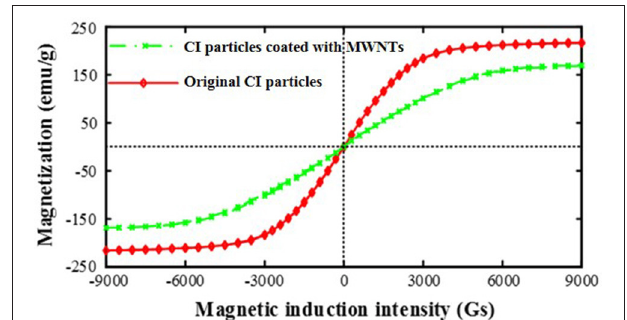
FIGURE 7 | Comparison of the magnetization curves of two kinds of the ferromagnetic particles (1Gs = 0.0795775kA/m).